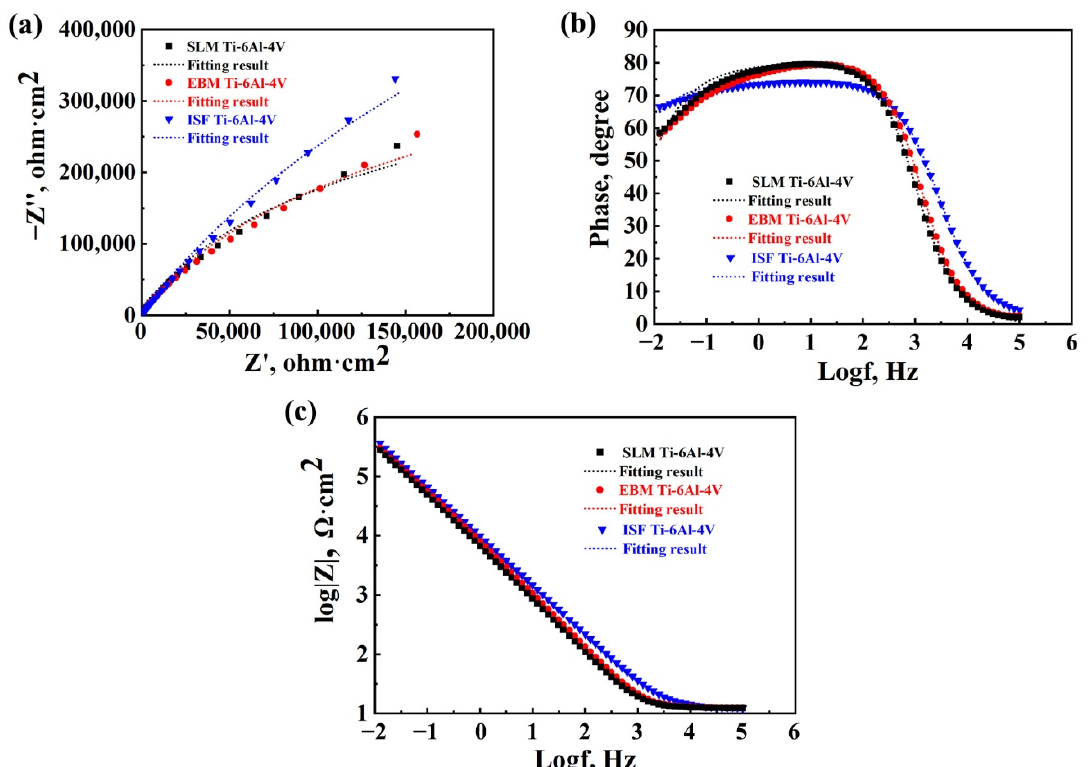
Figure 8. EIS results in the form of ( a ) a Nyquist plot, and ( b , c ) Bode plots for the SLM- and EBM-manufactured Ti-6Al-4V alloy samples and ISF alloy sample in a 3.5 wt.% NaCl solution.